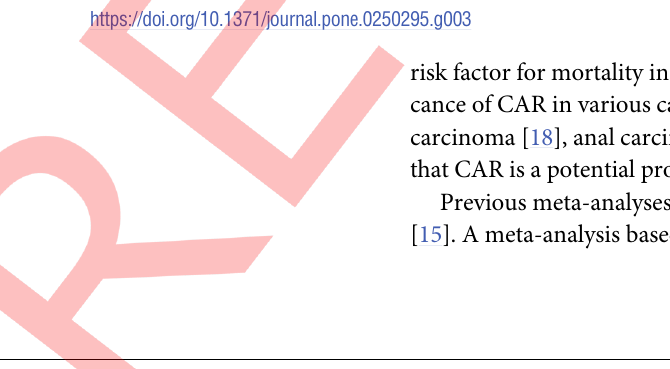
PLOS ONE | https://doi.org/10.1371/journal.pone.0250295 April 26,